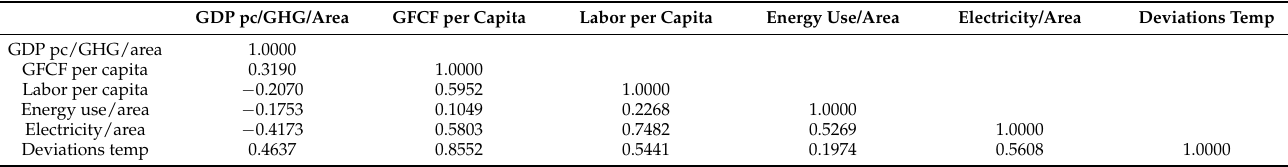
Table A1. Correlation matrix for inputs and outputs in DEA eco-efficiency ratios computed: 2008–2018 period. See Table 1a for data